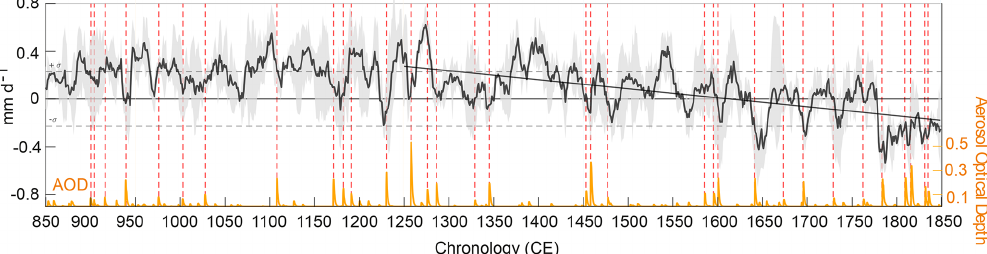
Figure 5. Multidecadal Sahel rainfall variability in IPSL-CM6A-LR past1000 simulations. Black line: 10-year low-pass-filtered index of Sahel JAS precipitation anomalies averaged in boxed area in Fig. 3 (i.e., 10–18 ◦ N and17.5 ◦ W–10 ◦ E). The black line corresponds to the ensemble mean, the gray shading to the ensemble spread and the diagonal line to the 1250–1849CE linear fit. Dashed horizontal lines show the ± standard deviation of the equivalent piControl index. The volcanic forcing used in the IPSL-CM6A-LR model experiments is shown by the orange curve as the globally averaged aerosol optical depth (AOD). Red vertical dotted lines indicate the occurrence of strong volcanic eruptions about the size or larger that the Pinatubo eruption (June 1991) defined when the tropical (20 ◦ S–20 ◦ N) or northern extratropical (50–90 ◦ N) mean AOD is larger than